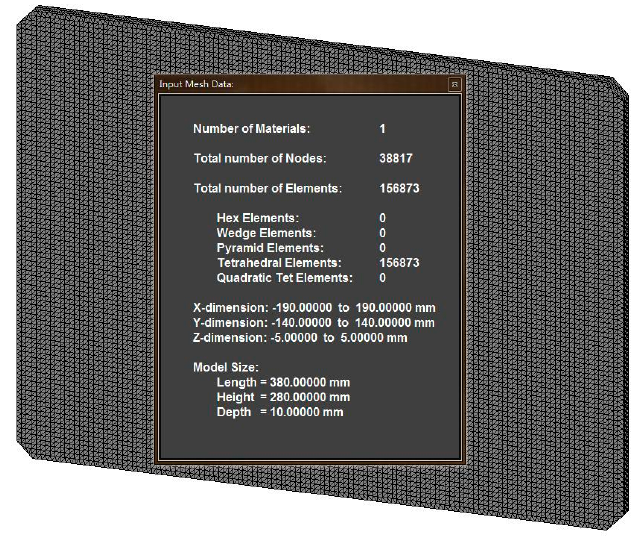
Figure 1. Exhibition of meshed slice model.